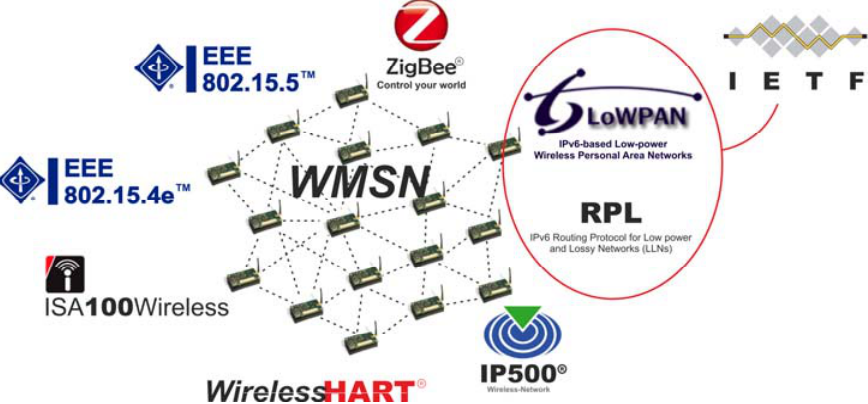
Figure 1. Most relevant standards and proposals which provide LR-WPANs with mesh capability.